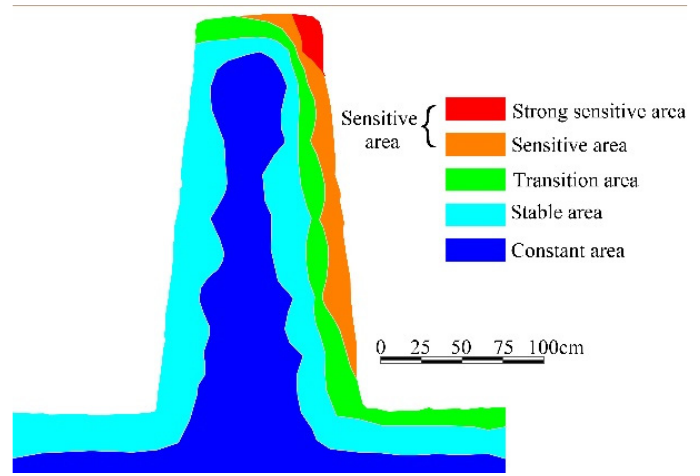
Figure 15. Temperature field of test wall in autumn.